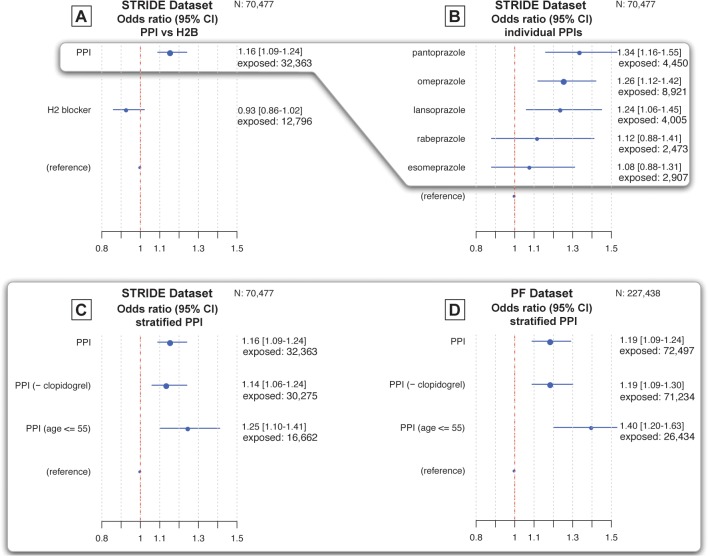
PPI use is associated with an increased risk for MI, regardless of age or clopidogrel use.No association is identified for H2 Blocker use: In the fig, the dotted red line represents the reference point indicating no elevated risk for myocardial infarction (MI). The odds ratio and 95% confidence interval for each exposure are indicated by a blue dot and blue line, respectively, which are also represented numerically to the right of each fig. The size of the dot is proportional to the exposure size of each group (see Table 1). Fig A, derived from STRIDE (N = 70,477), shows that PPIs have a class-level effect for MI in the general population of patients with GERD. By comparison, H2 blockers, an alternate treatment, have no association. Fig B breaks down the associations for each PPI individually. Figs C and D use stratification to show that the signals are corroborated in two independent datasets (STRIDE and Practice Fusion) and are robust in important subgroups. Fig C shows that, for the STRIDE dataset, when patients on clopidogrel are excluded, the associations are unchanged. Also, in lower-risk age groups for MI, the associations are still present. Similar trends are seen in these subgroups in the Practice Fusion (PF) dataset (N = 227,438) shown in Fig D.